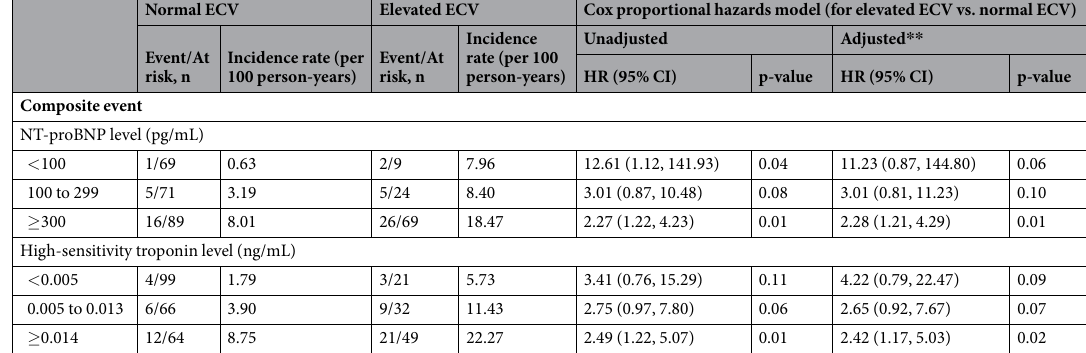
Table 7. Risk of the composite event, stratified by categories of NT-proBNP and high-sensitivity troponin T level. * Absolute risk difference is defined as the incidence rate difference (95% CI) between elevated ECV and normal ECV groups. ** Adjusted for age, gender and black ethnicity in multivariable models. NT-proBNP,